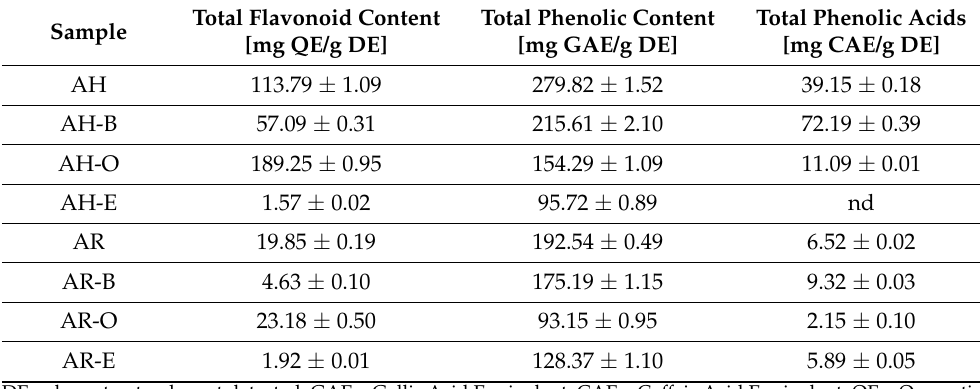
Table 1. The total content of phenolic (TPC), flavonoid (TFC), and phenolic acids (TPAC) in the aerial parts and roots of A. acutiloba